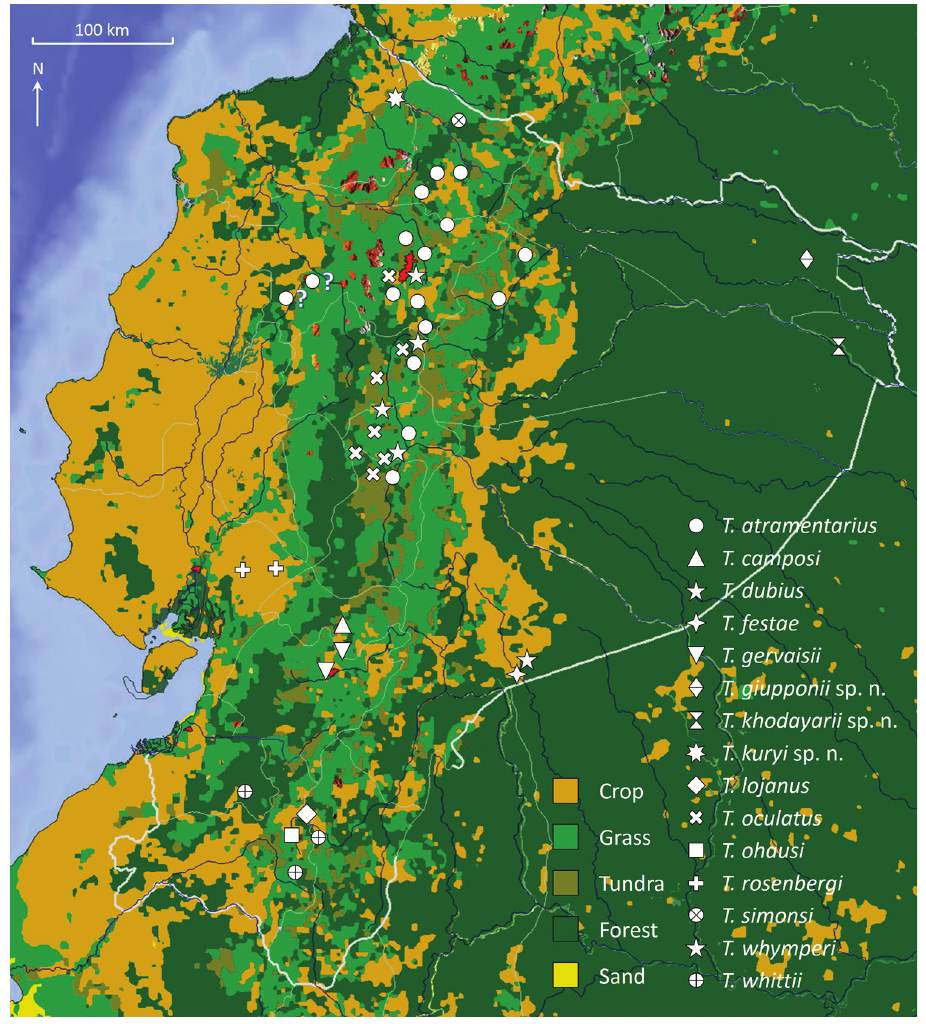
Figure 2. Vegetation map of Ecuador showing the distribution of the known species of Teuthraustes